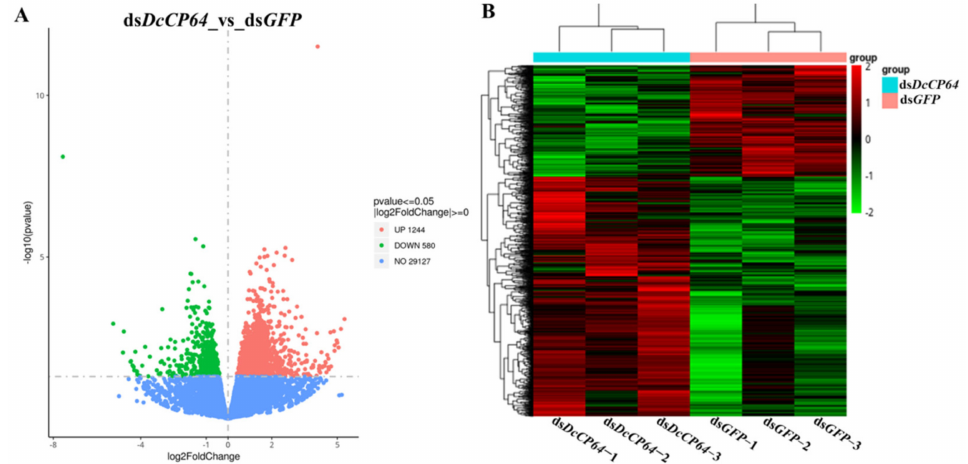
Figure 9. The identification and hierarchical cluster analysis of differentially expressed genes (DEGs) in treatment groups (ds DcCP64 ) and control groups (ds GFP ). ( A ) A scatter diagram for each gene. The blue, red and green points represent no difference in expression, up-regulated genes and down- regulated genes, respectively. ( B ) Hierarchical clustering of DEGs between ds DcCP64 and ds GFP groups. Columns indicate different samples. Rows represent different DEGs. Green bands indicate a low expression level, and red bands indicate a high gene expression level.